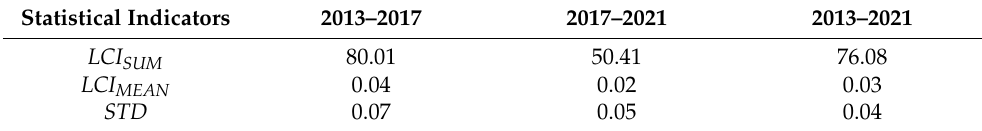
Table 5. LCI statistics’ results.